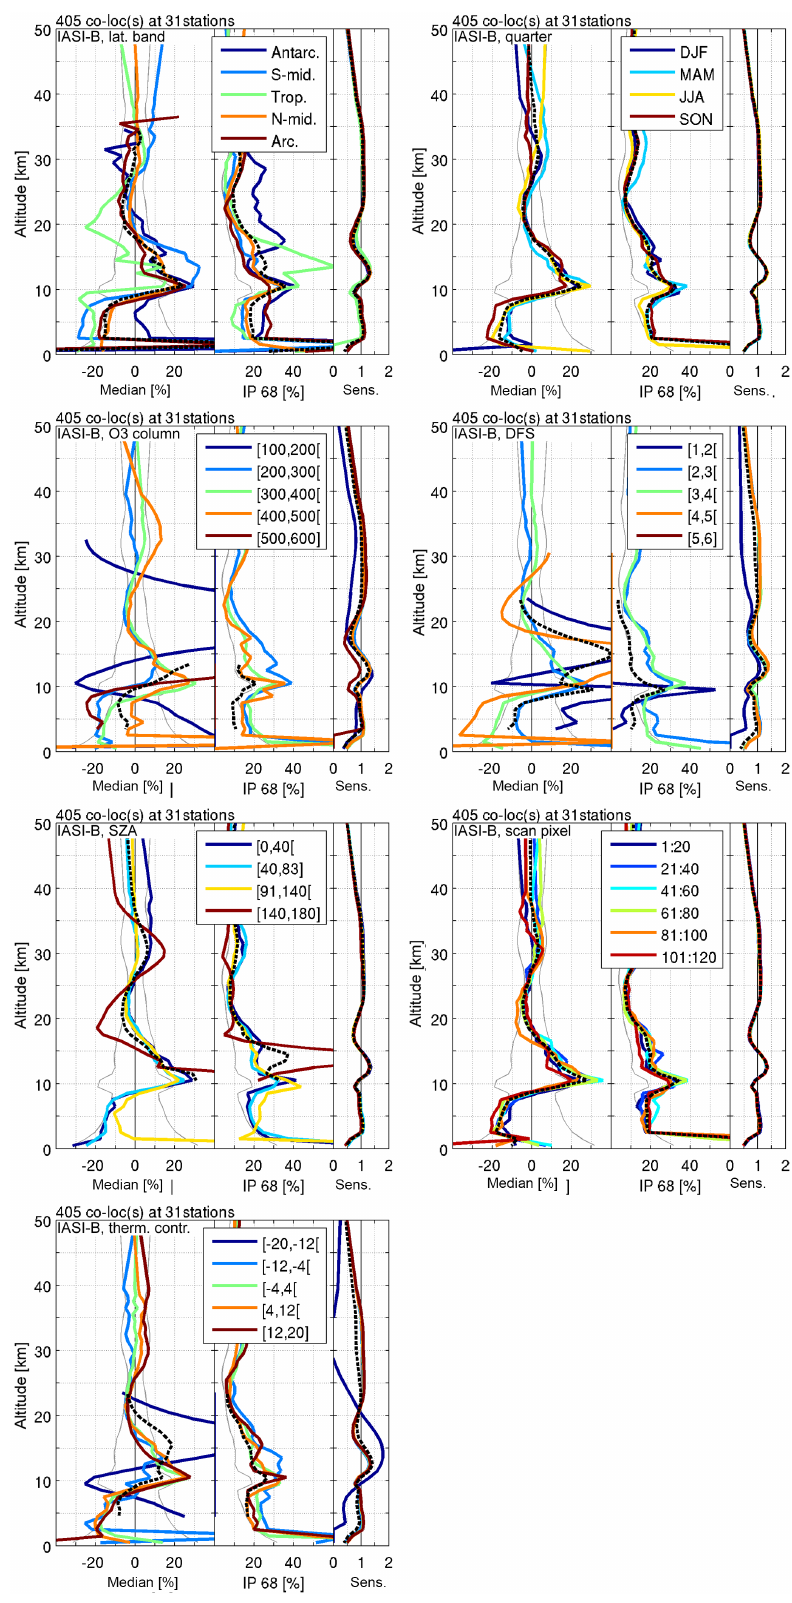
Figure 15. As for Fig. 14, but for FORLI v20151001L2 IASI-B data (2013–2015). Because of the limited temporal extent of this product, no drift study has been